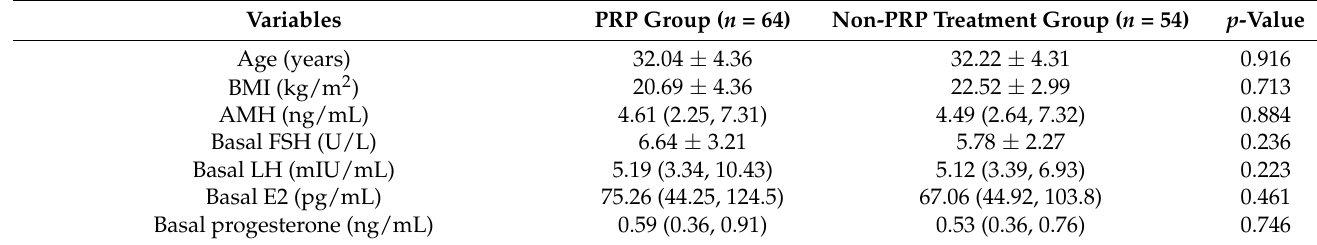
Table 1. Baseline characteristics of the PRP and non-PRP